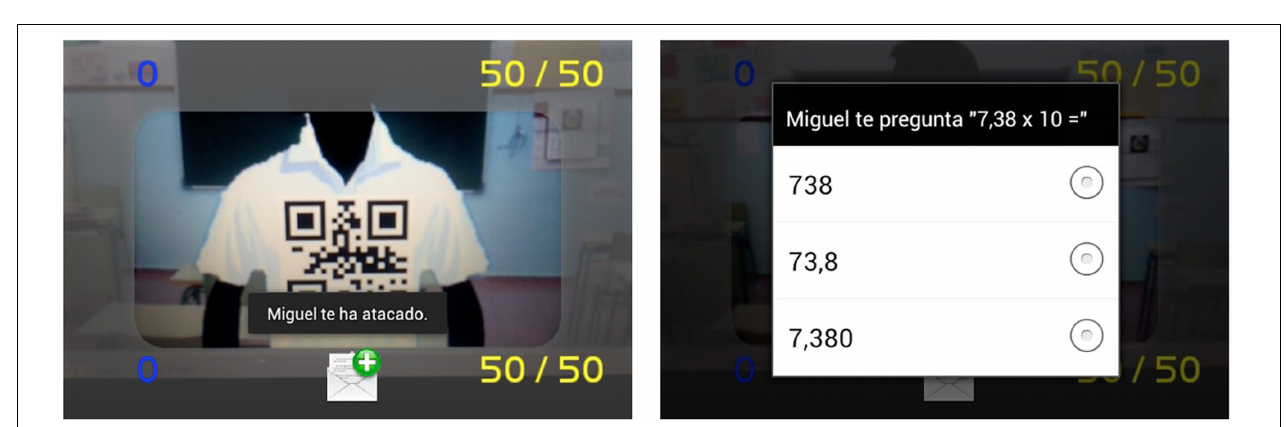
FIGURE 8 | Mobile screen selecting a fellow student.